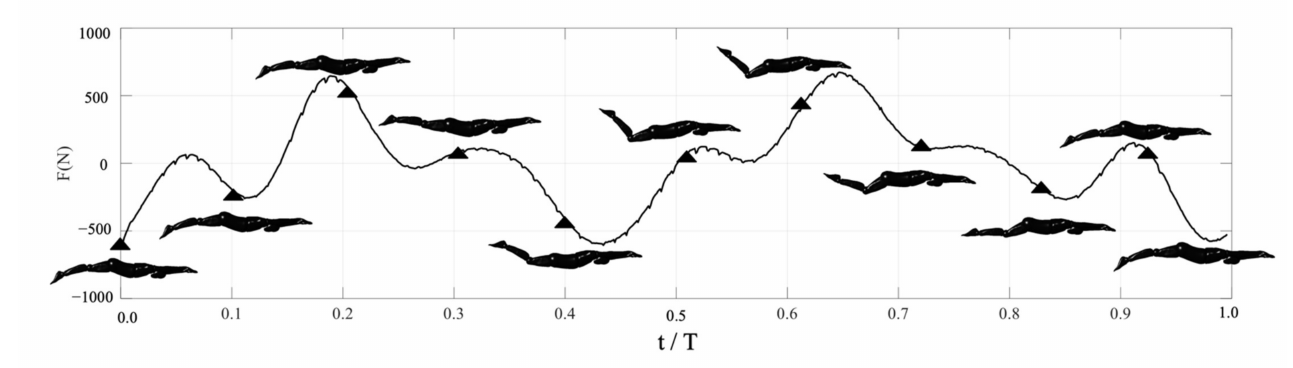
Figure 7. Corresponding diagram of instantaneous action and net streamwise